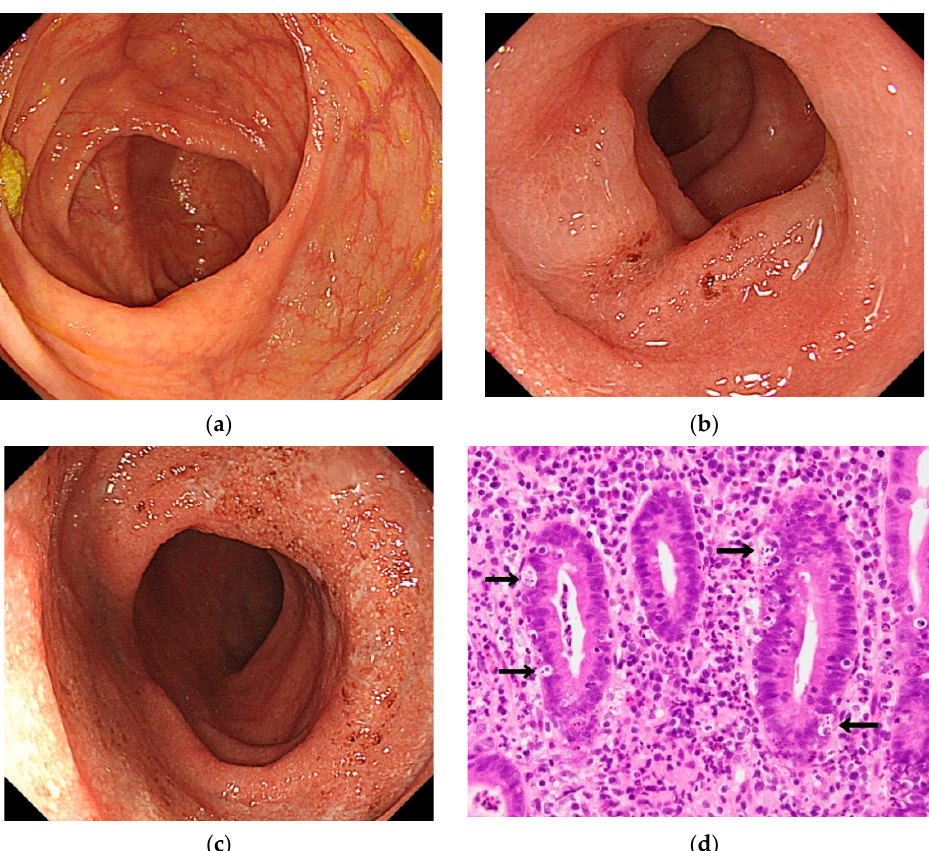
Figure 1. First colonoscopy findings after admission. Continuous coarse granular mucosa up to the sigmoid colon is observed. Apoptosis (arrows) is readily apparent in the pathological image. Pathological findings include epithelial apoptosis, infiltration of mixed inflammatory cells consisting of neutrophils, lymphocytes, and plasma cells, cryptitis, and crypt abscess. The apoptotic image shows the tendency of miniaturization and fusion of the crypt epithelium. The apoptoses was 14 per 10 crypts: ( a ), cecum; ( b ), sigmoid colon; ( c ), rectum; ( d ), pathological image of sigmoid colon.